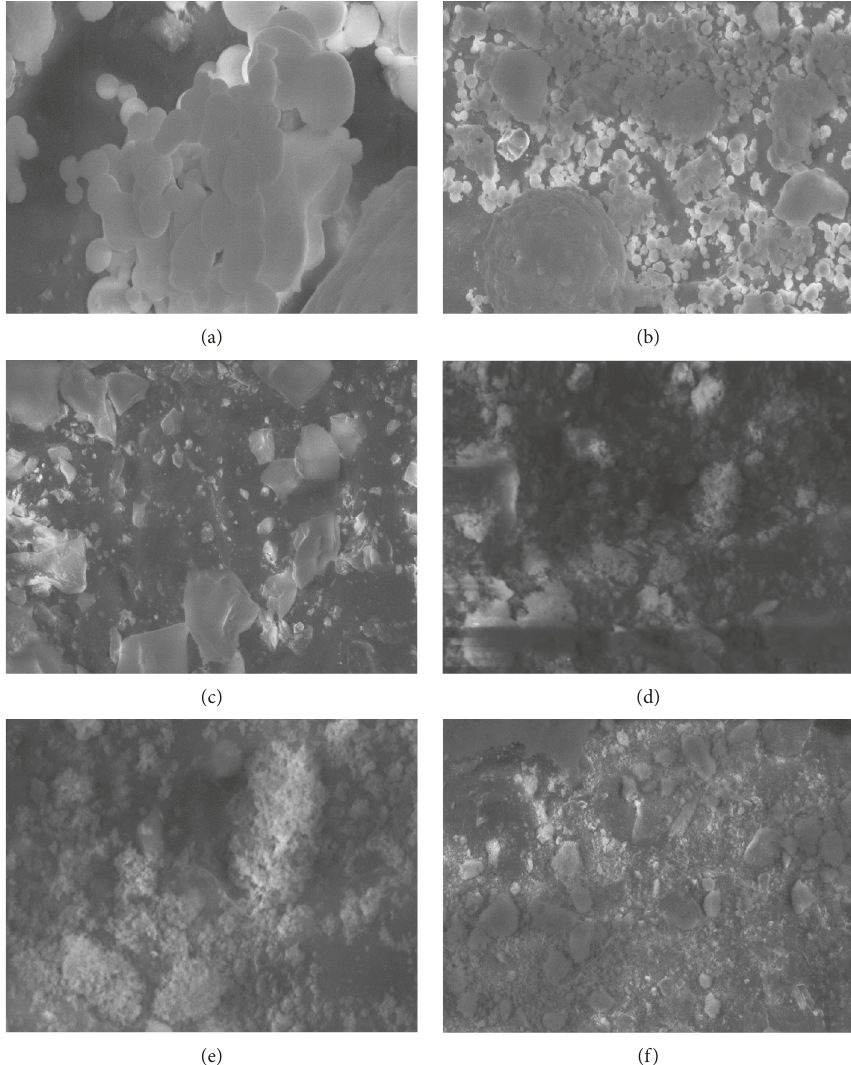
Figure 5: SEM images of modified samples. (a, b) SBA-16; (c, d) SBA-16 (120 ° C); (e, f) SBA-16 modified by